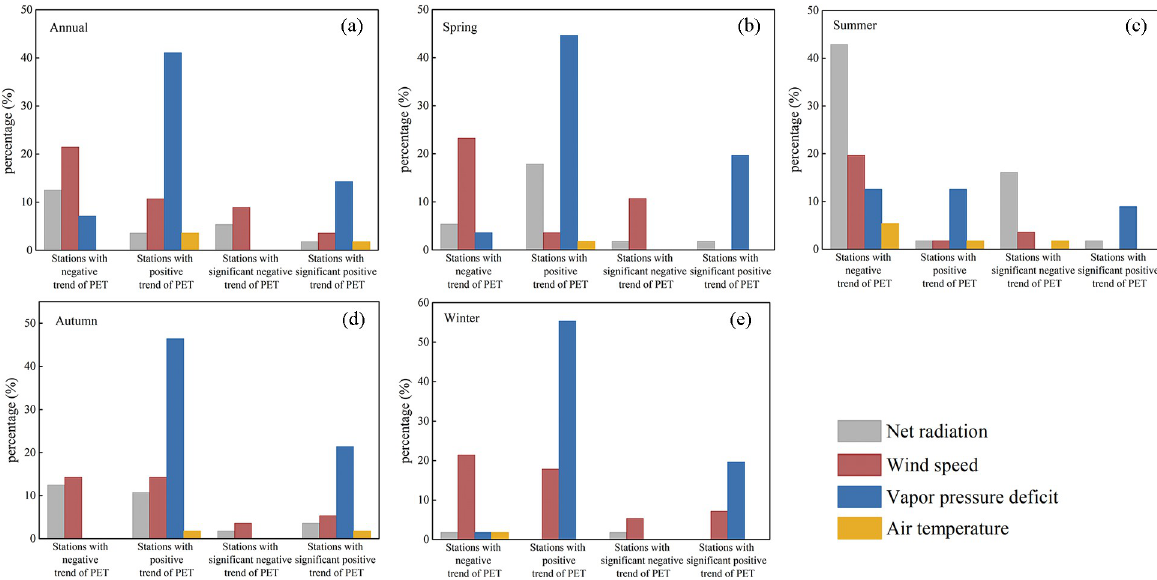
Fig 10. Dominant factors are shown as percentages for stations with negative, positive, significantly negative ( p < 0.05) and significantly positive ( p < 0.05) trends of PET in (a) annual, (b) spring, (c) summer, (d) autumn and (e) winter.